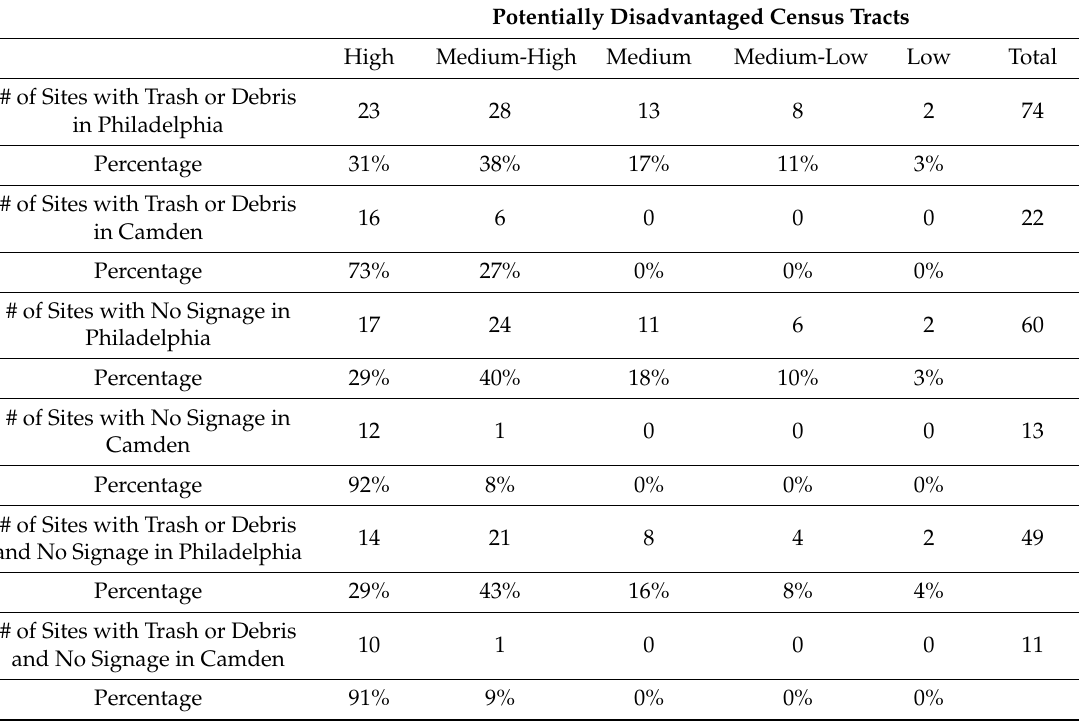
Table5. NumberofGSISiteswithTrash / DebrisandNoSignagewithinPotentiallyDisadvantagedTracts. Potentially Disadvantaged Census Tracts High Medium-High Medium Medium-Low Low